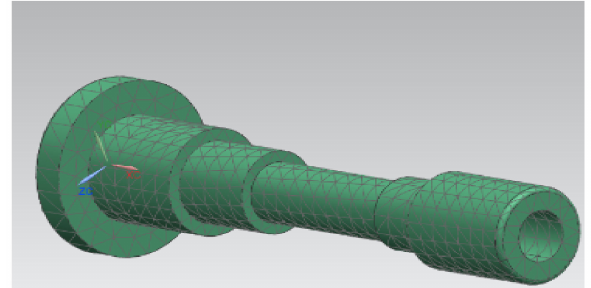
Figure 2. SPB tetrahedral mesh.